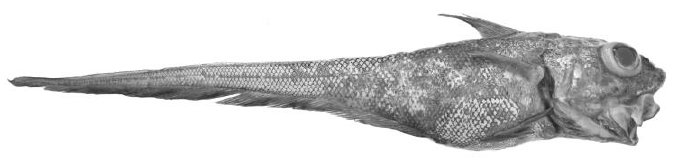
Figure 2. Sample image of M. caml .